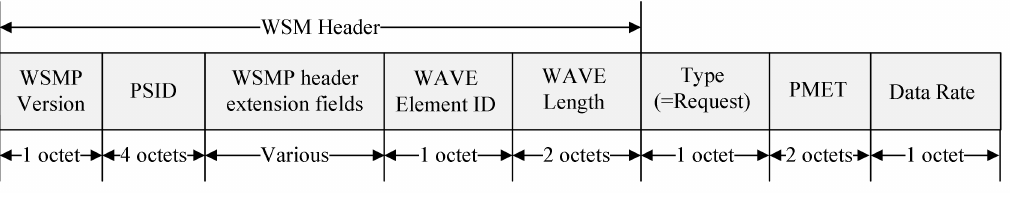
Figure 3. The format of the proposed Coop Request